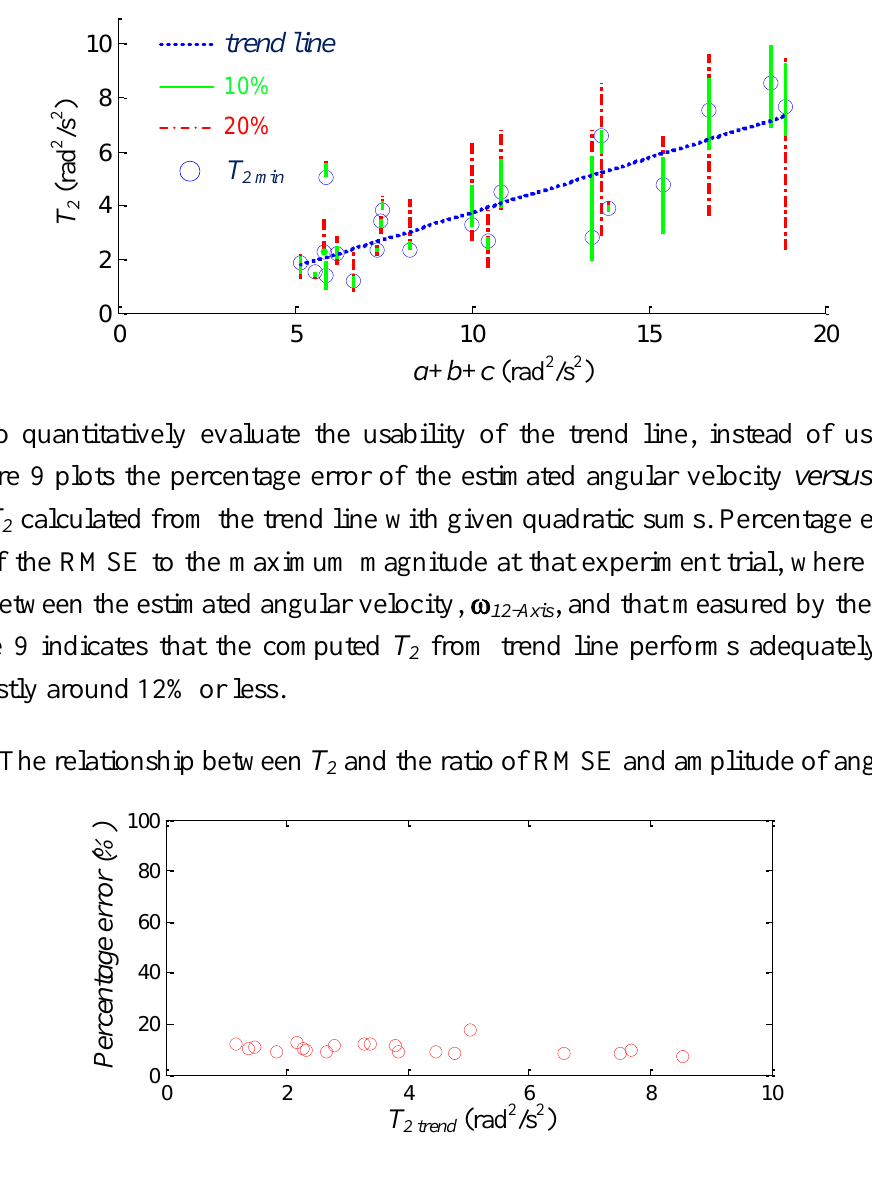
Figure 8. The relation between amplitude of motion and T